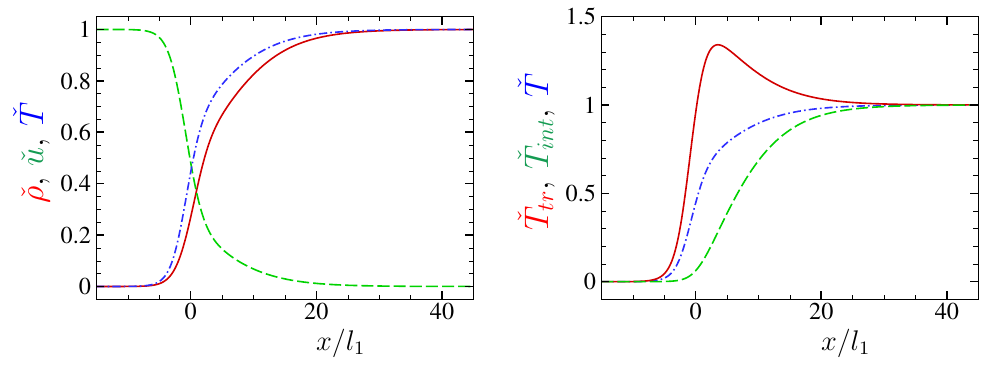
Figure 10. Profiles of ˇ ρ , ˇ u , ˇ T , ˇ T tr , and ˇ T int at M = 2 in the case of δ = 4, θ = 0.05, and ν = 0.5 (Pr = 1.905, µ b / µ = 4). See the caption of Figure